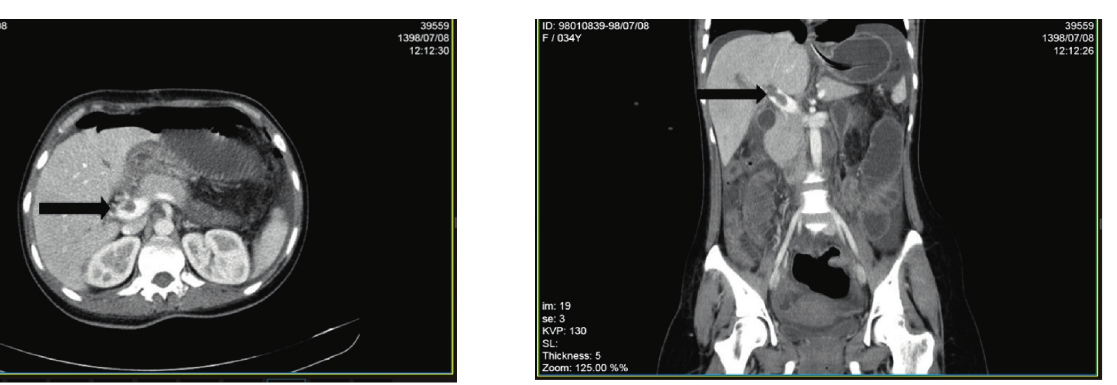
Figure 1: Thrombosis in main portal vein in spiral abdominal CT scan with IV contrast (black arrow).